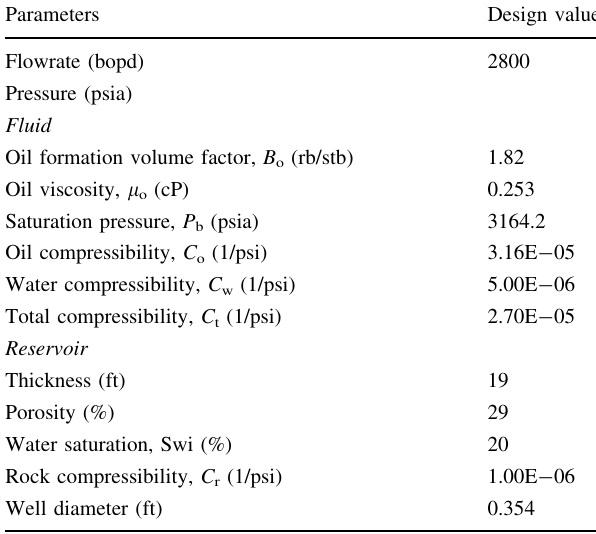
Fig. 7 Miller et al. (1950) semi-log for low K boundary Table 3 Reservoir and fluid data